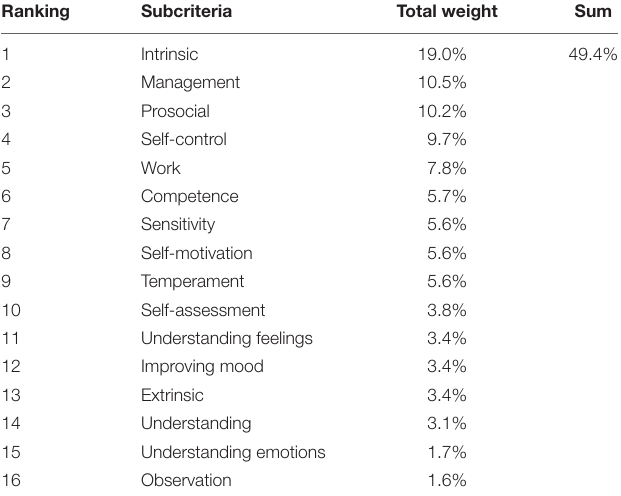
TABLE 2 | Ranking of